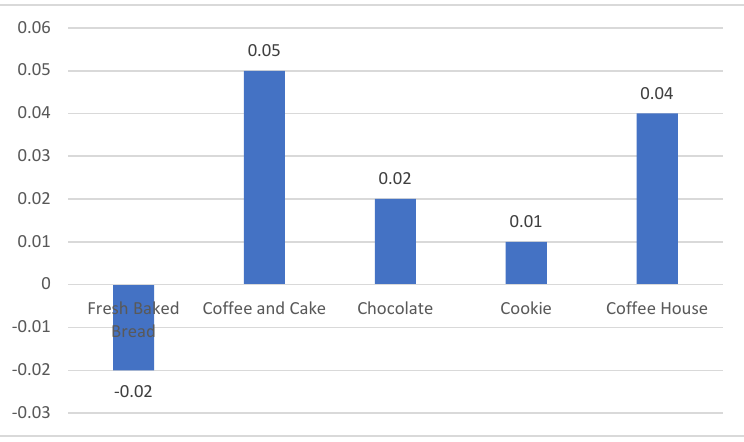
Figure 12. Valence for testing aromas under laboratory conditions.